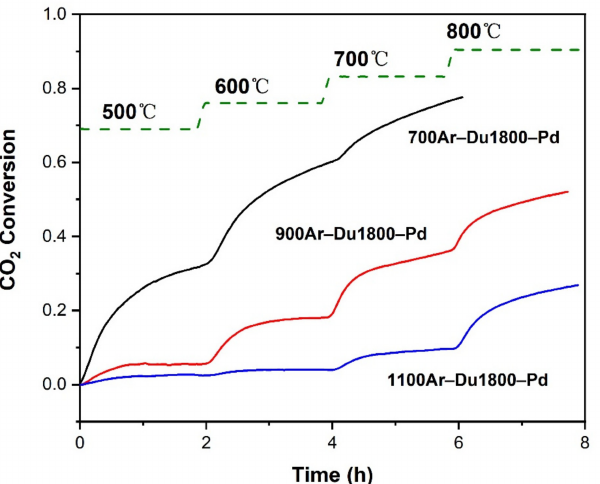
Figure 9. CO 2 conversion in the DRM tests in a recirculating batch reactor with an initial CH 4 :CO 2 :Ar= 1:1:8 mixture at 1000 mbar initial